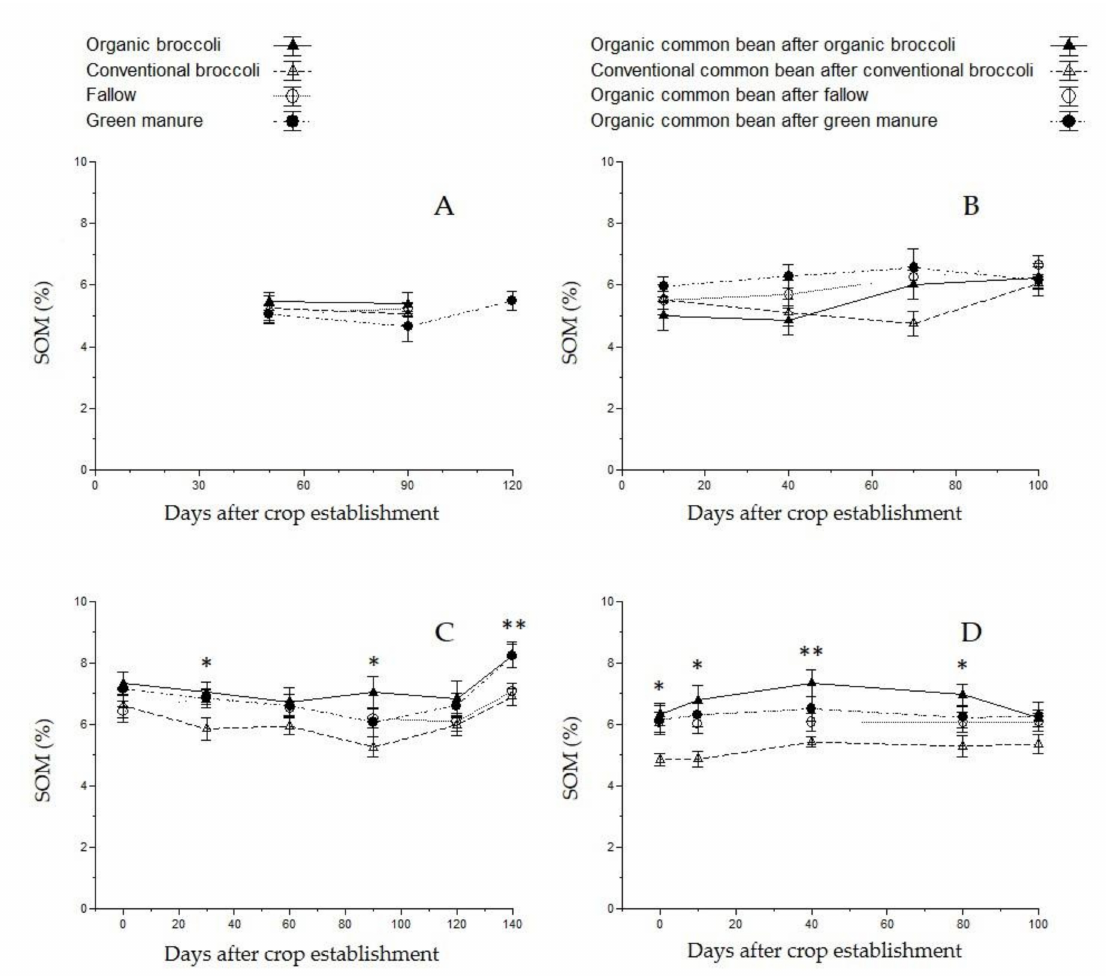
Figure 8. Impact of pre-crop treatments during the wintertime on soil organic matter (SOM) during the two experimental years. Vertical bars indicate standard errors of means (n = 8), while * and ** indicate significant di ff erences according to Duncan’s multiple range test ( p < 0.05), significant at p < 0.05 and p < 0.01, respectively. ( A ) SOM in the di ff erent treatments applied as preceding crops during autumn-winter 2017–2018, particularly at 50, 90, and 120 days after crop establishment (DACE). ( B ) SOM after crop establishment, at the 50% flowering stage, during harvest, and at crop termination (10, 40, 70, and 100 DACE) in the common bean crop during spring-summer 2018 as influenced by the preceding winter crop. ( C ) SOM before basal dressing, after crop establishment, at the stage of broccoli flower head formation, at crop termination of broccoli, at 50% flowering of faba bean, and after incorporation of plant residues into the soil (0, 30, 60, 90, 120, and 140 DACE) in the di ff erent treatments applied as preceding crops during autumn-winter 2018–2019. ( D ) SOM before and after the establishment of common bean crop, at the 50% flowering stage, at harvest, and at crop termination (0, 10, 40, 80, and 100 DACE, respectively) during spring-summer 2019, as influenced by the preceding winter